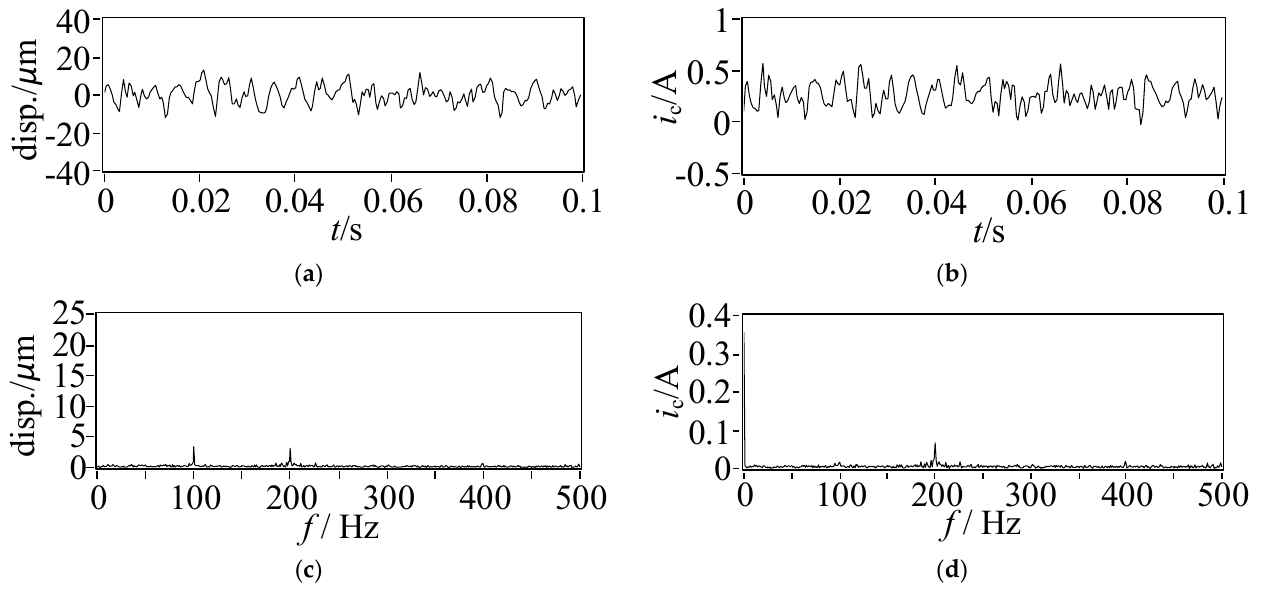
Figure 10. The amplitude-frequency diagram of displacement and current after rotor LMS compensation. ( a ) Time domain spectrum of displacement; ( b ) Time domain spectrum of current; ( c ) Frequency spectrum of displacement; ( d ) Frequency spectrum of current.